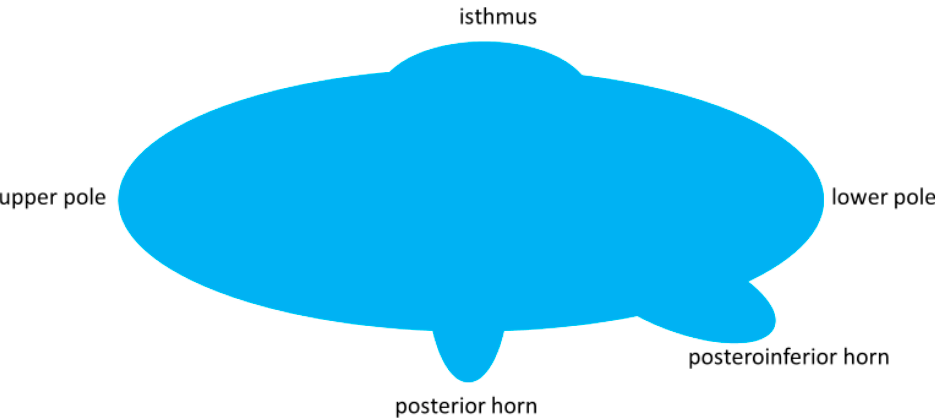
Figure 2. Stylized sagittal view of the thyroid gland. Note the posterior and the posteroinferior horn as protrusions at the back. These protrusions as well as the upper and lower extremities of the thyroid lobe and the isthmus are introduced as poles of the thyroid gland for the purpose of a pole concept of nodule growth to be developed in the discussion section.